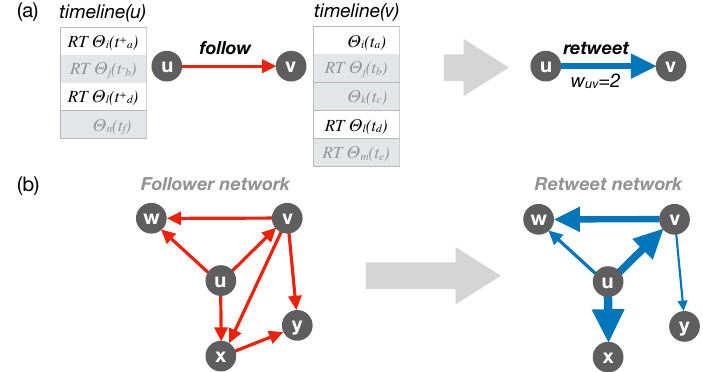
Figure 1. ( a ) Construction of the retweet network R [ t , t (cid:48) ] . In the timelines of u and v , we distinguish tweets Θ from retweets RT Θ . Given that u follows v , we consider that u retweeted v if u retweeted a tweet or a retweet of v at a posterior time point. In this example, this includes two retweets: Θ i , which has been posted by v at t a and retweeted by u at t + a > t a , as well as Θ l , which has been retweeted by v at t d as well as u at t + d > t d . However, this does not include Θ j , which u retweeted at t − b < t b . Other tweets and retweets not common to both timelines are naturally ignored. The weight of the retweet link from u to v is thus w uv = 2. ( b ) The retweet network R [ t , t (cid:48) ] is therefore a weighted sub-network of F t : in both networks, the link direction from u to v is aligned with observed attention from u to v .